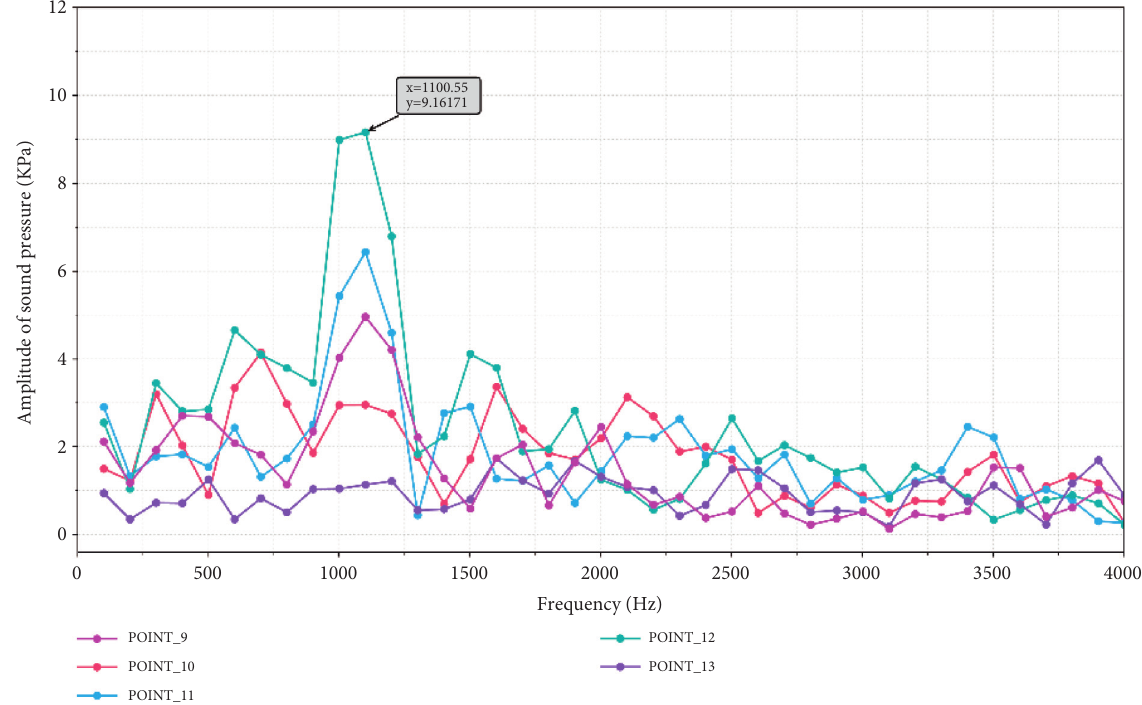
Figure 23: Frequency spectrums of P9, P10, P11, P12, and